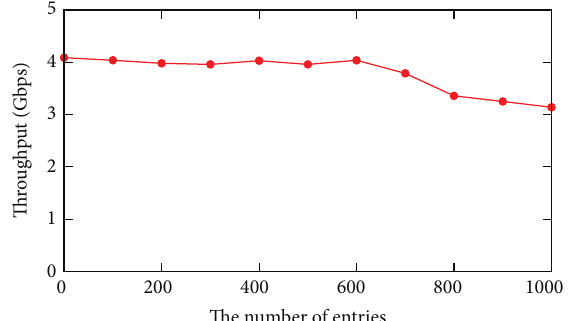
Figure 14: Evaluation on the effect of data plane